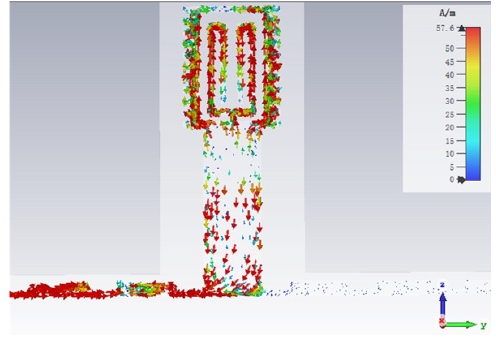
Figure 6. The current distribution of sensing unit.